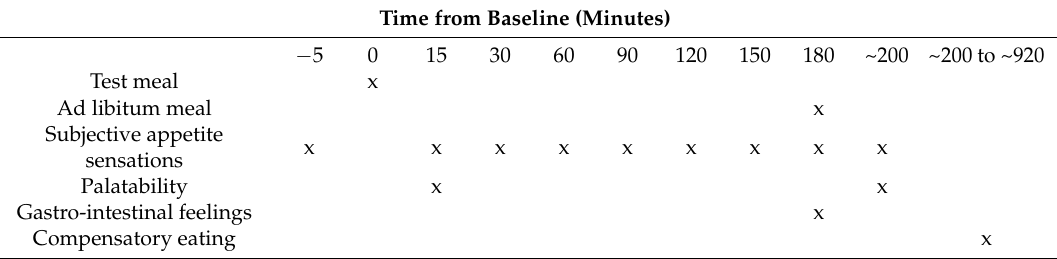
Table 1. Timeline of the measurements on each test